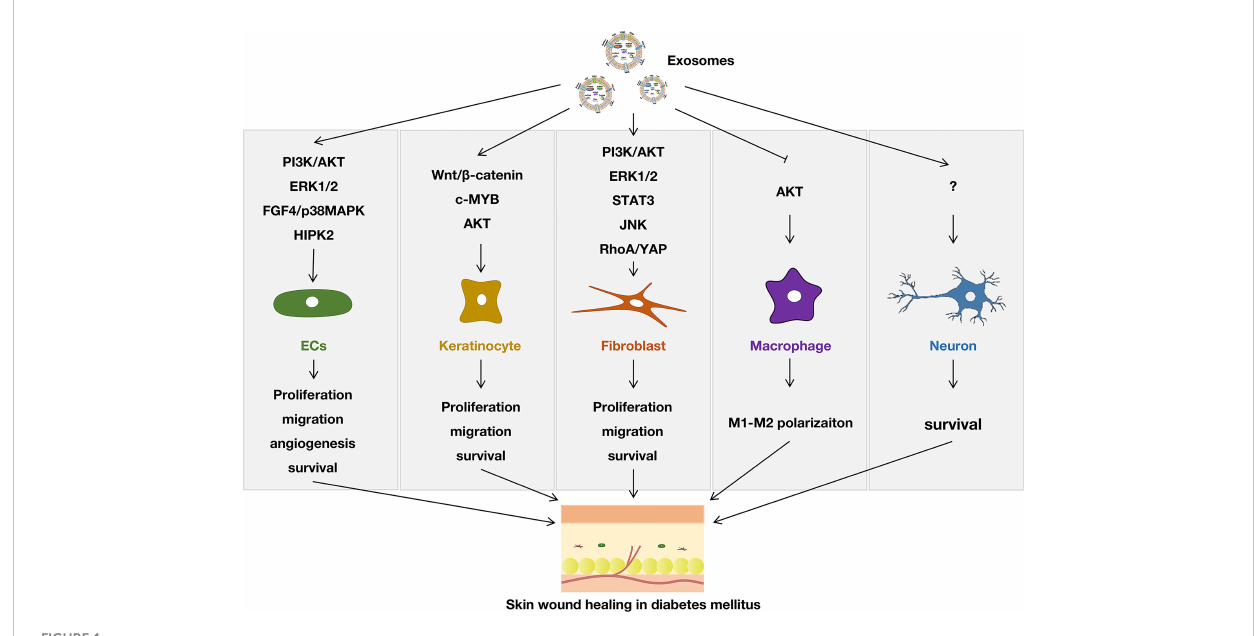
FIGURE 1 Effect of exosomes on modulating different cells in diabetic skin wound